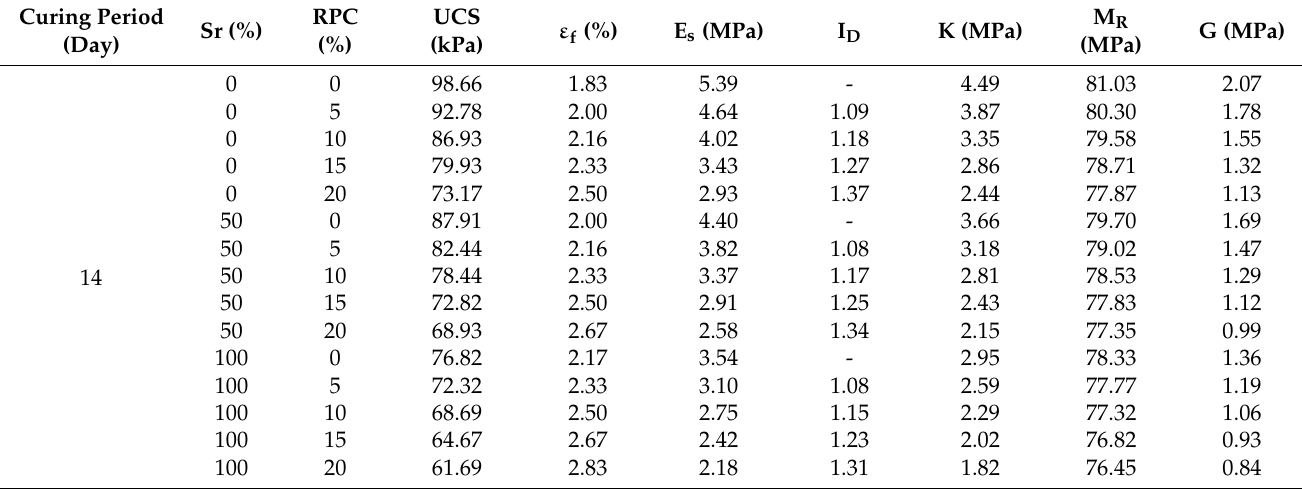
Table 4. Geotechnical properties of Group A of the